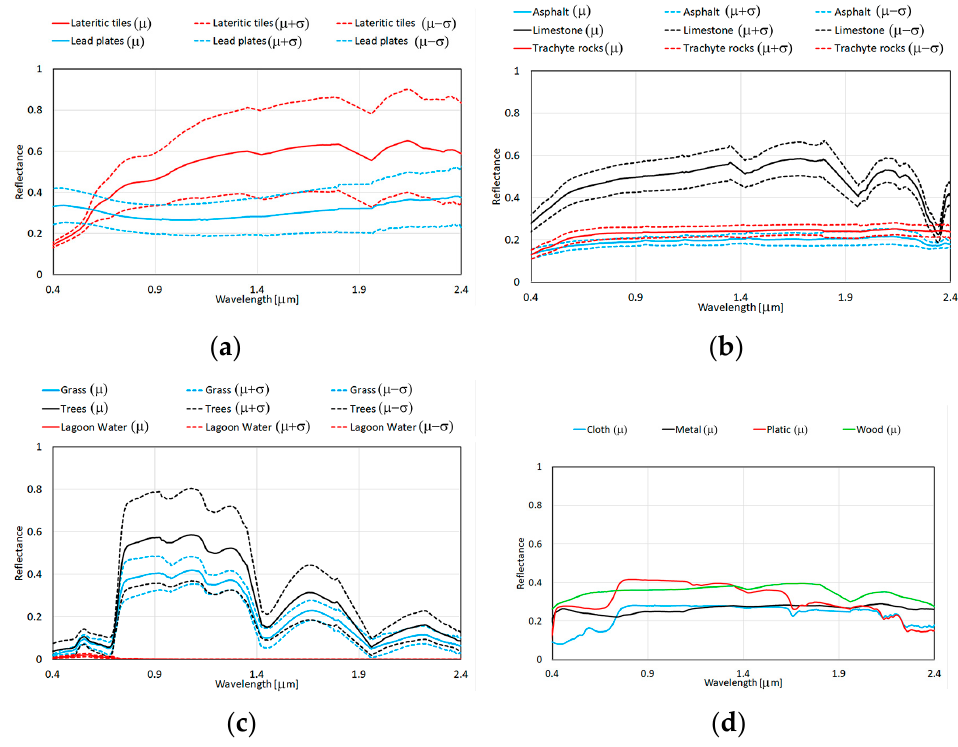
Figure 4. The spectral library (i.e., the mean spectra and the mean spectra plus and minus standard deviation values): ( a ) the spectra of lateritic tile and lead plate endmembers; ( b ) the spectra of asphalt, limestone, and trachyte rock endmembers; ( c ) the spectra of grass, tree, and lagoon water endmembers; ( d ) the spectra of cloth, metal, plastic, and wood endmembers.